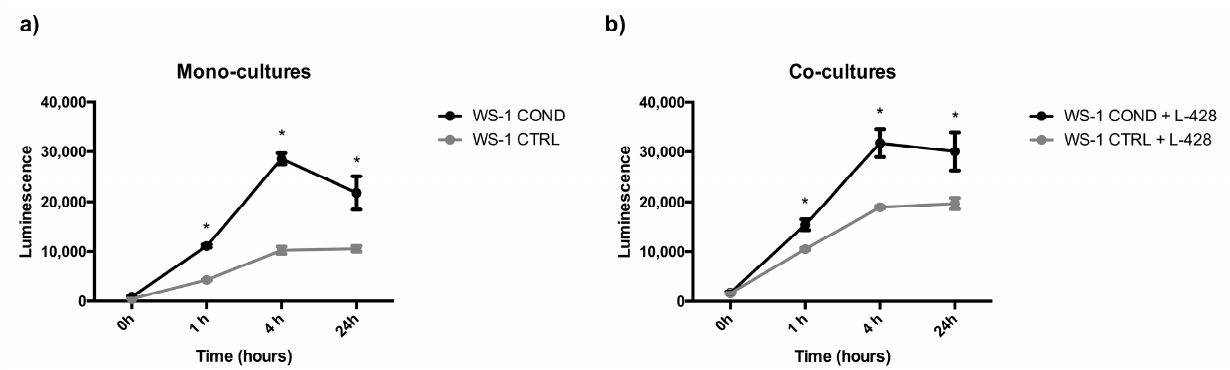
Figure 5. ( a ) Spheroid mono-cultures (WS-1 COND vs. WS-1 CTRL) viability assessed by RealTime- Glo assay. ( b ) Spheroids co-cultures (WS-1 COND + L-428 vs. WS-1 CTRL + L-428) viability assessed by RealTime-Glo assay. * p < 0.05